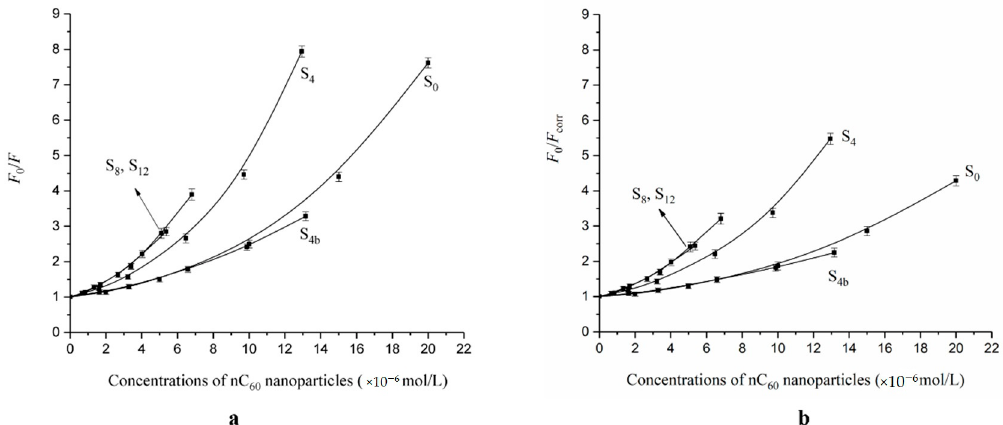
Figure 2. The fluorescence quenching plots of BSA by nC 60 with ( a ) and without ( b ) correction of the fluorescence inner filter effect.